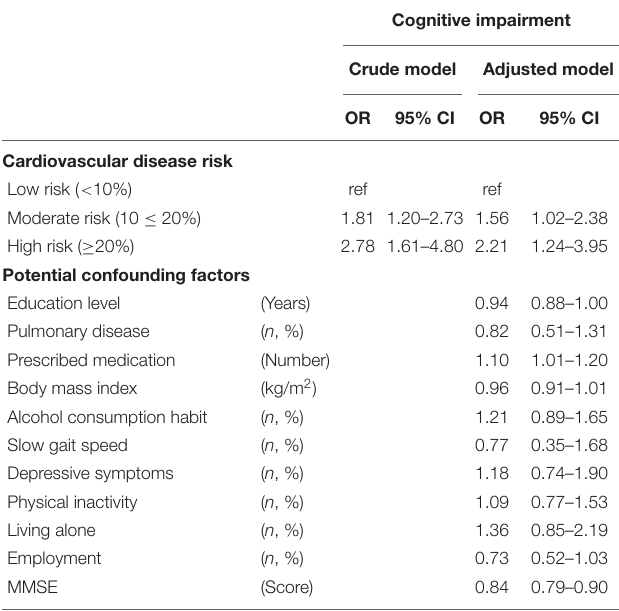
TABLE 3 | Odds ratios and 95% confidence intervals for incidence of cognitive impairment according to CVD risk